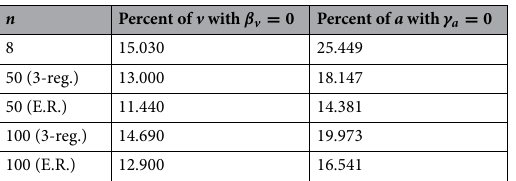
n (cid:31) m (cid:30)